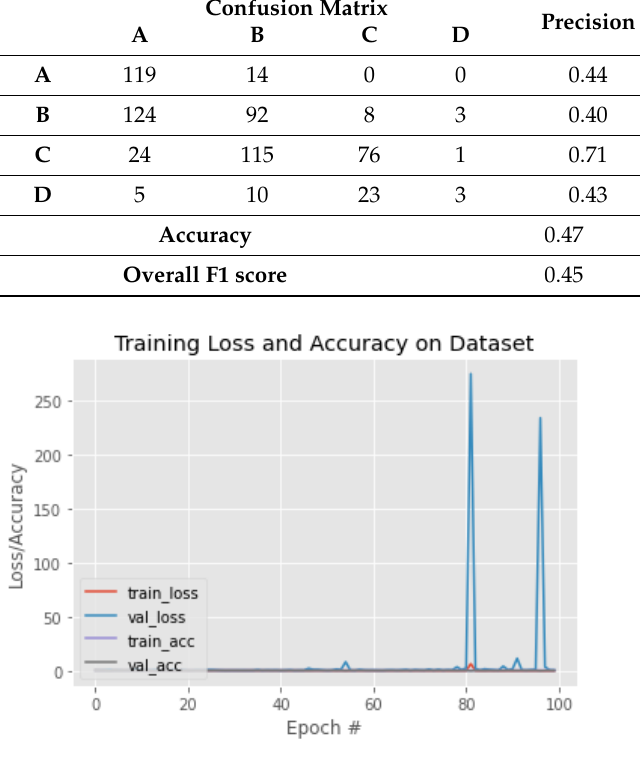
Figure 13. The training behavior of the model based on ResNet50.